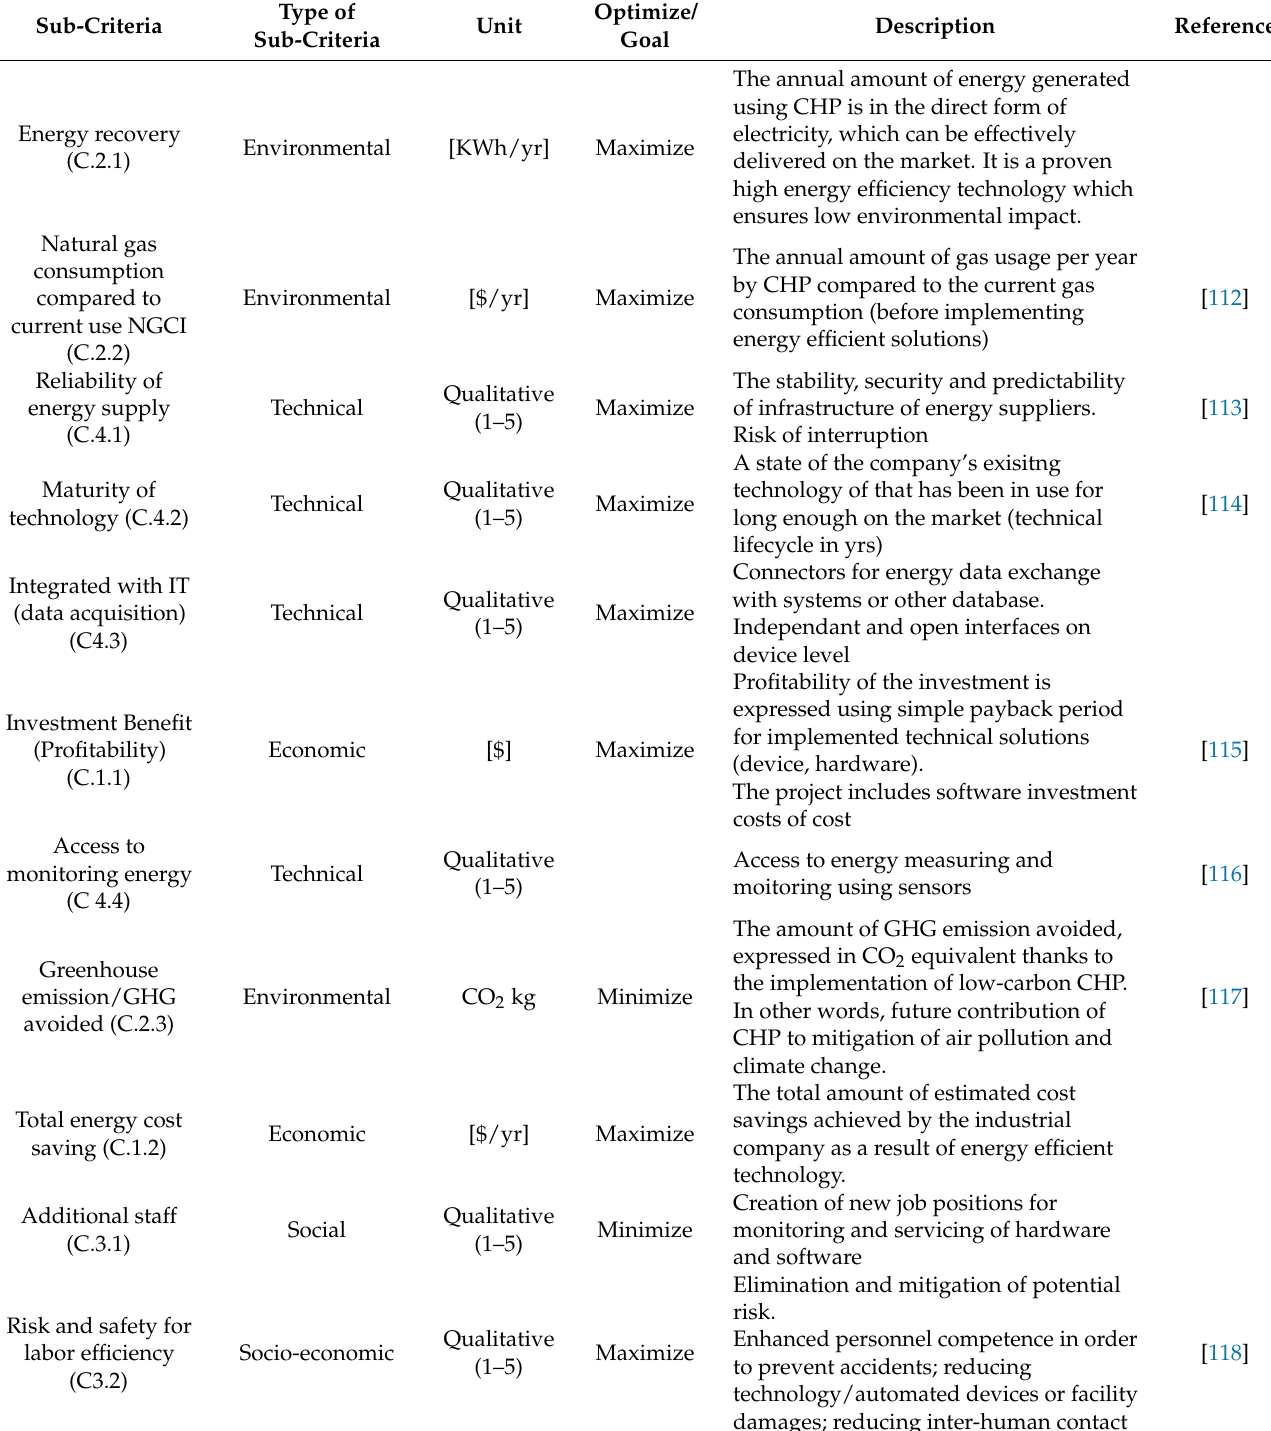
Table 5. Identified sub-criteria and their detailed contents for evaluating energy sustainability of energy technology within Industry